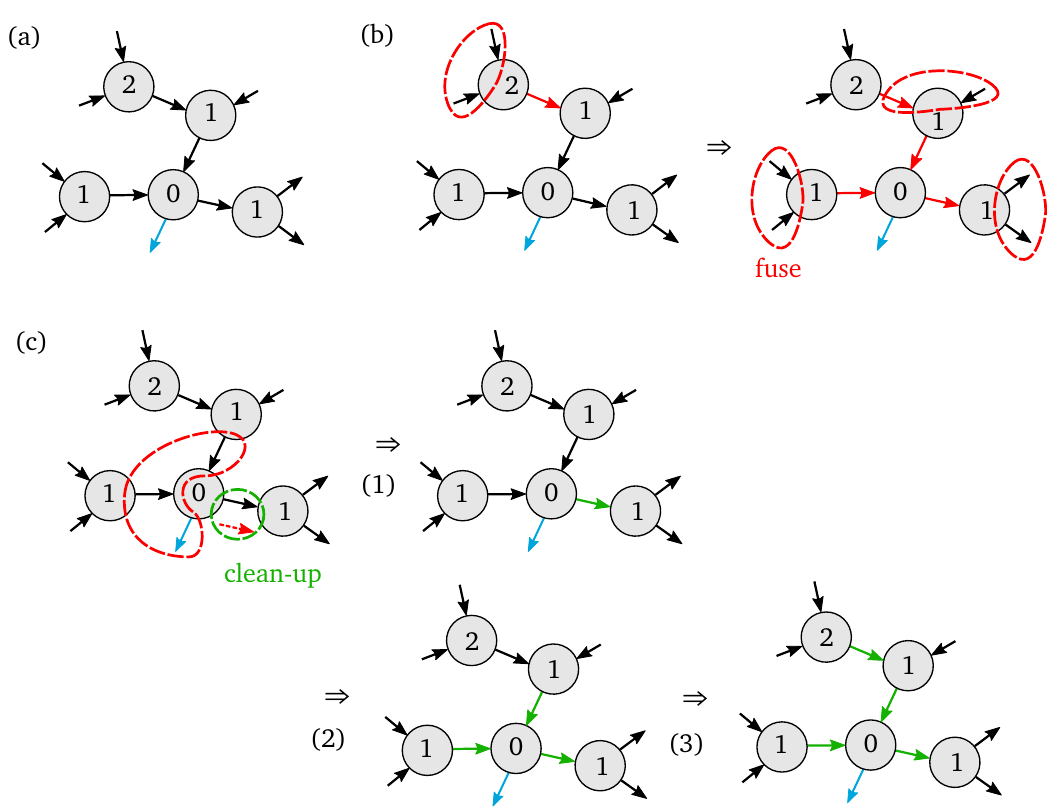
Figure 33: First steps in the preparation of a randomized symmetric ansatz state: (a) Set up a level-structure, assign directions for symmetric links and equip the TN with a selector link (blue). (b) Build up virtual links by means of fusing: Starting from the physical links, fuse links at nodes of the highest level to obtain the links towards the next lower level; successively repeat this procedure until reaching the center. (c) Clean-up round: (1) Intersection (green circle) with fused link (red dashed) yields cleaned-up link (green). (2) Clean up remaining virtual links at the center node. (3) Propagate the clean-up